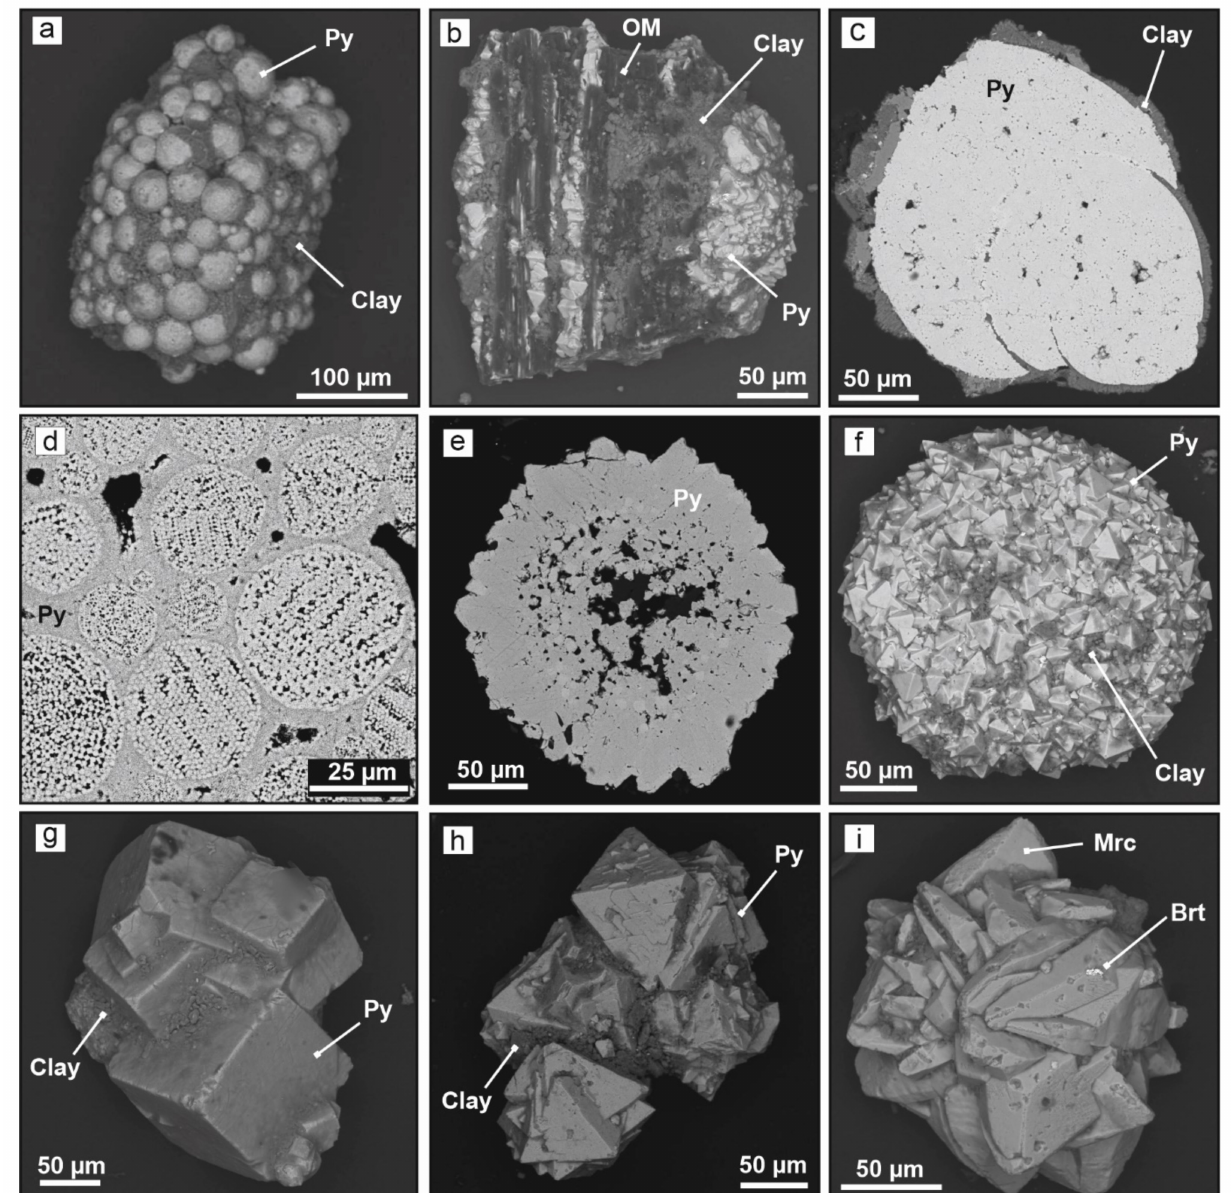
Figure 6. Back-scattered electron (BSE) images showing the morphology of pyrite ( a – h ) and marcasite ( i ) from mud masses extruded by South Sakhalin ( a ) and Pugachev ( b – i ) MVs. ( a ) Botryoidal aggregate of primary spherical pyrite framboids. ( b ) Pyrite layers in coal-bearing shale ( c ) Pseudomorphs after fossil remnant. ( d ) Botryoidal aggregate of spherical pyrite framboids buried in pyrite matrix. Most framboids are ordered and filled. ( e ) Sunflower structures with framboidal core rimmed by radiating outer crystals. ( f ) Pseudomorph after fossil remnant composed of octahedral crystals that formed during the final stage of the framboids recrystallization. ( g ) Intergrowth of large cubic pyrite crystals coexisting with clay. ( h ) Octahedral pyrite crystals and their aggregates. Some crystals are sputtered with microcrystals of later generations. ( i ) Tabular and prismatic crystals of marcasite coexisting with baryte. Brt = baryte; Mrc = marcasite; OM = organic matter; Py = pyrite. Both framboids and crystals of pyrite show 34 S depletion relative to seawater sulfates (Figure 7). The δ 34 S values are lower in crystals than in framboids: +14.0‰ to +14.8‰ CDT for South Sakhalin (US-18-6-1) and +14.2‰ to +15.8‰ for Pugachev (PG-18-8-1) mud samples against +18.5‰ to +19.3‰ (US-18-6-1) and +19.6‰ (US-18-1-3) for South Sakhalin MV and +18.0‰ for the same Pugachev sample. The δ 34 S values of large